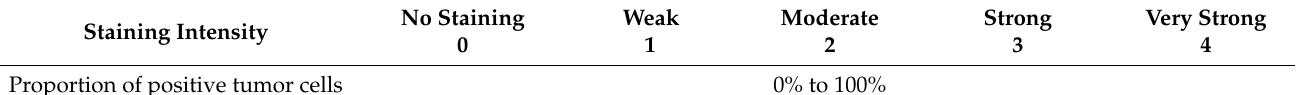
Table 3. Epidermal growth factor receptor (EGFR) immunostaining